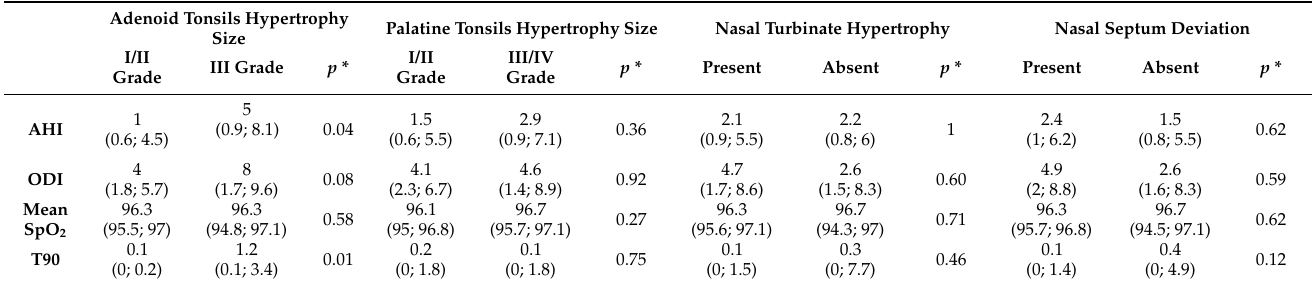
Table 6. Correlation between ear, nose, and throat data and major overnight polygraphy results in children with Down syndrome.